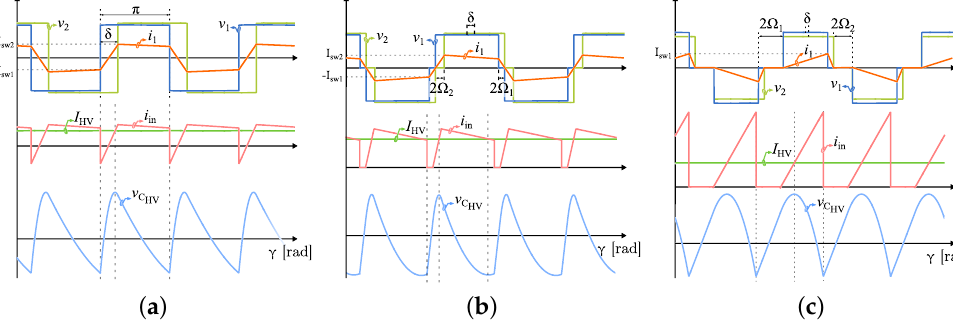
Figure 2. Main current and voltage waveforms of DAB converter: ( a – c ) are the primary and secondary voltage ( v 1 & v 2 ) and primary current ( i 1 ) in SPS rectangular, TPS-TPM and TPS-TRM, respectively, together with the input currents ( I HV & i in ) and voltage ripple ( v Forward-mode power transfer (from HV to